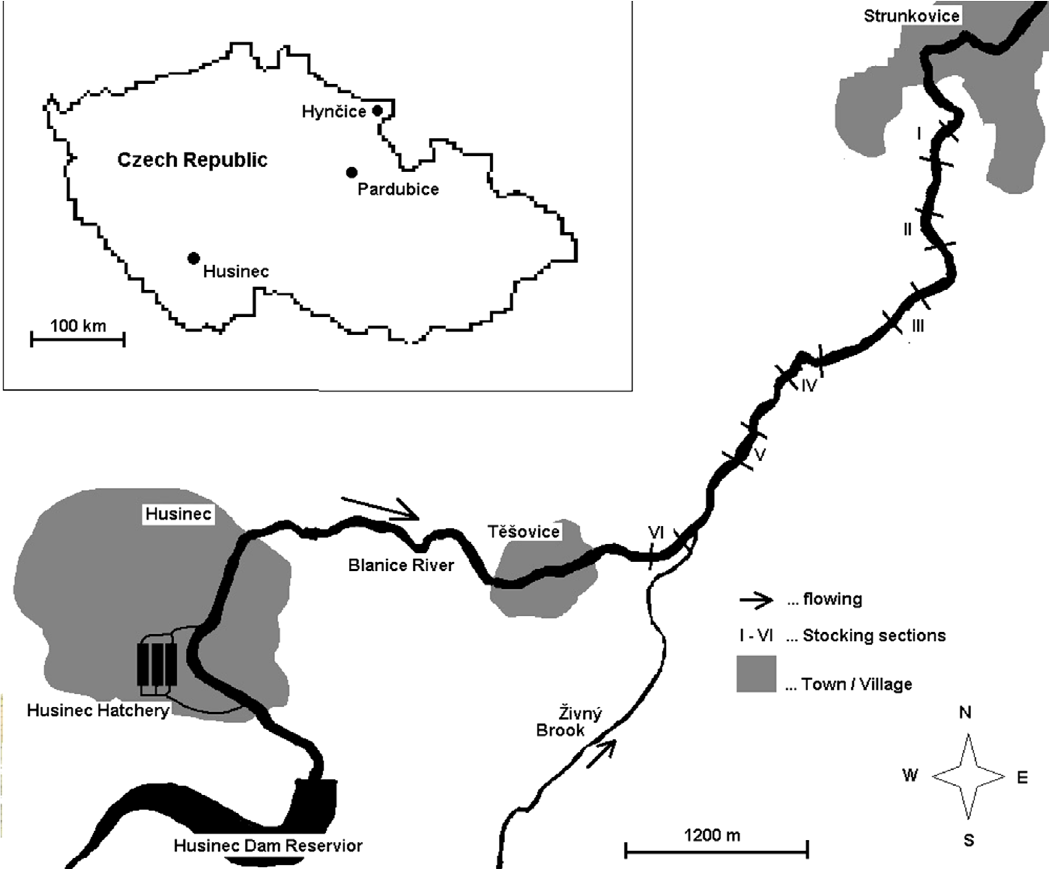
Fig. 1. Map showing the locations of release sites in the Blanice River. The inset shows location hatcheries producing the fi sh used in the